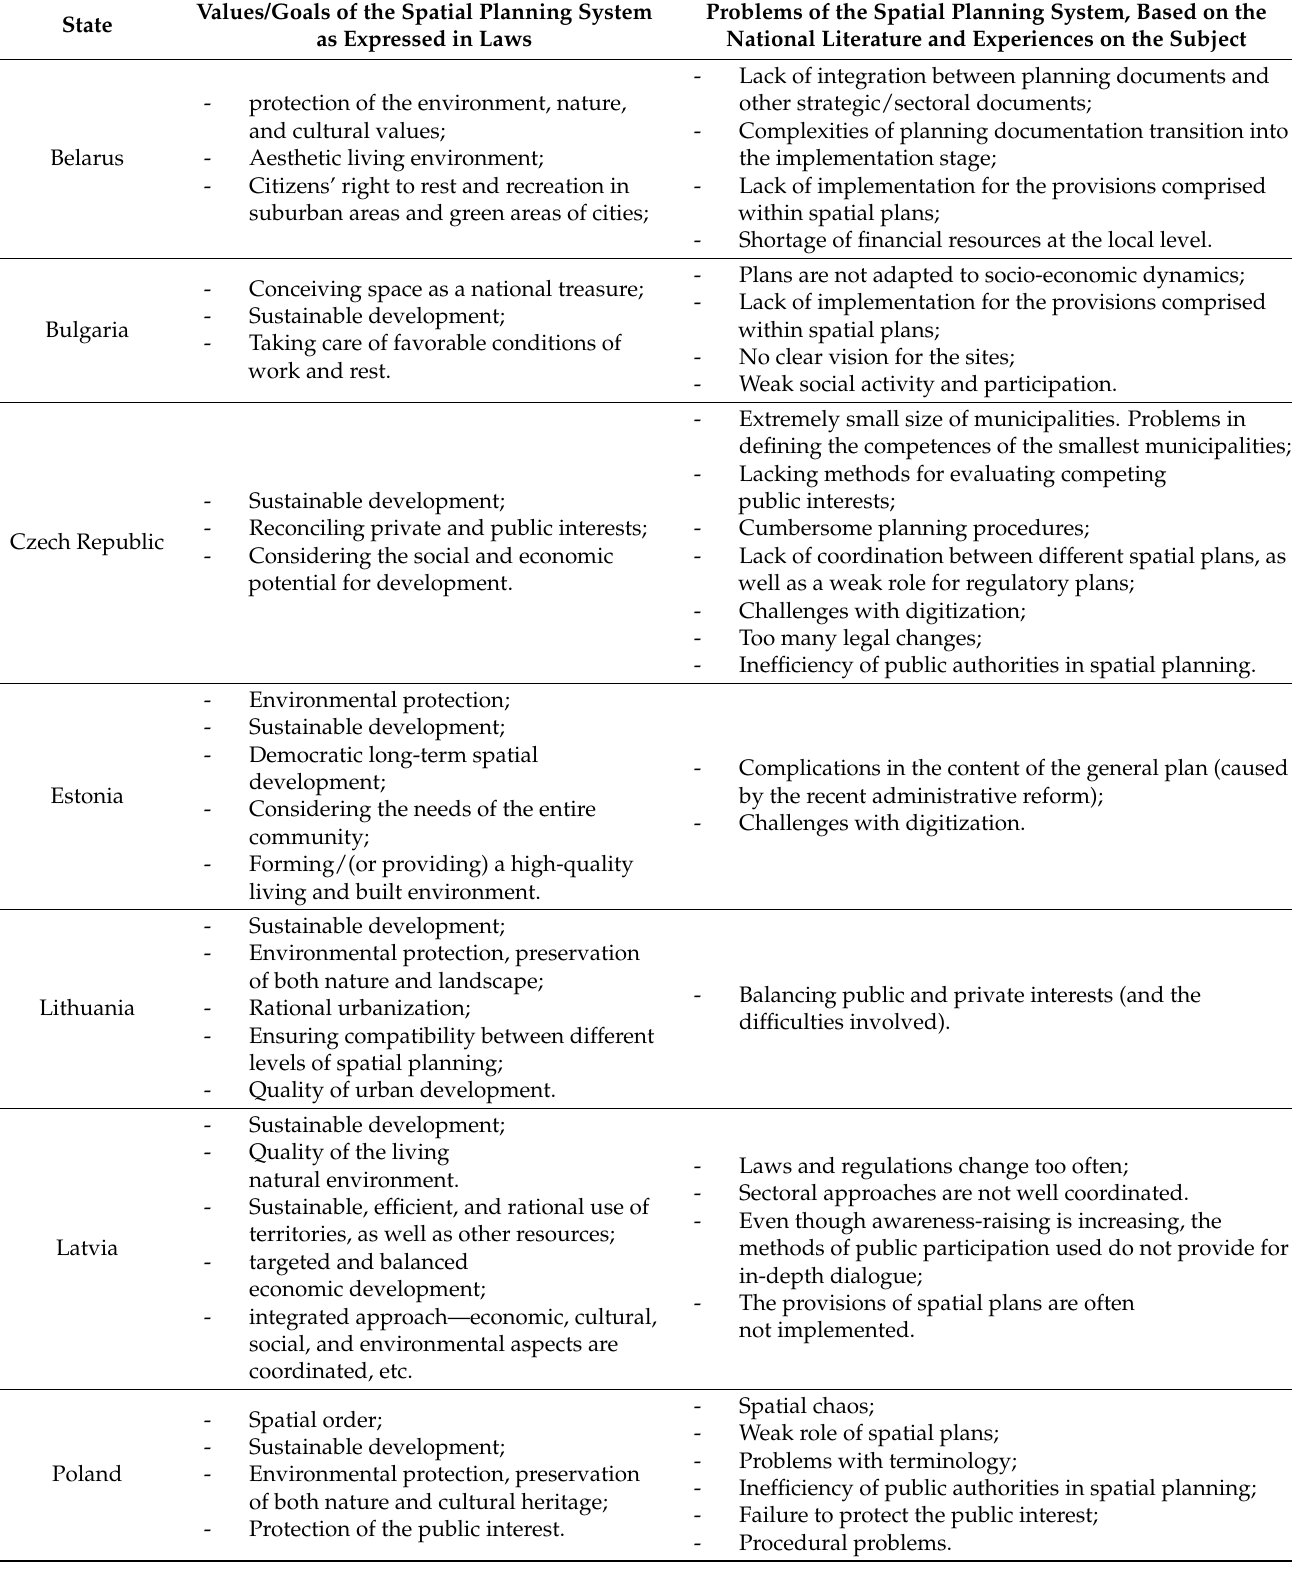
Table 1. Key values and main problems in national spatial planning systems at the local